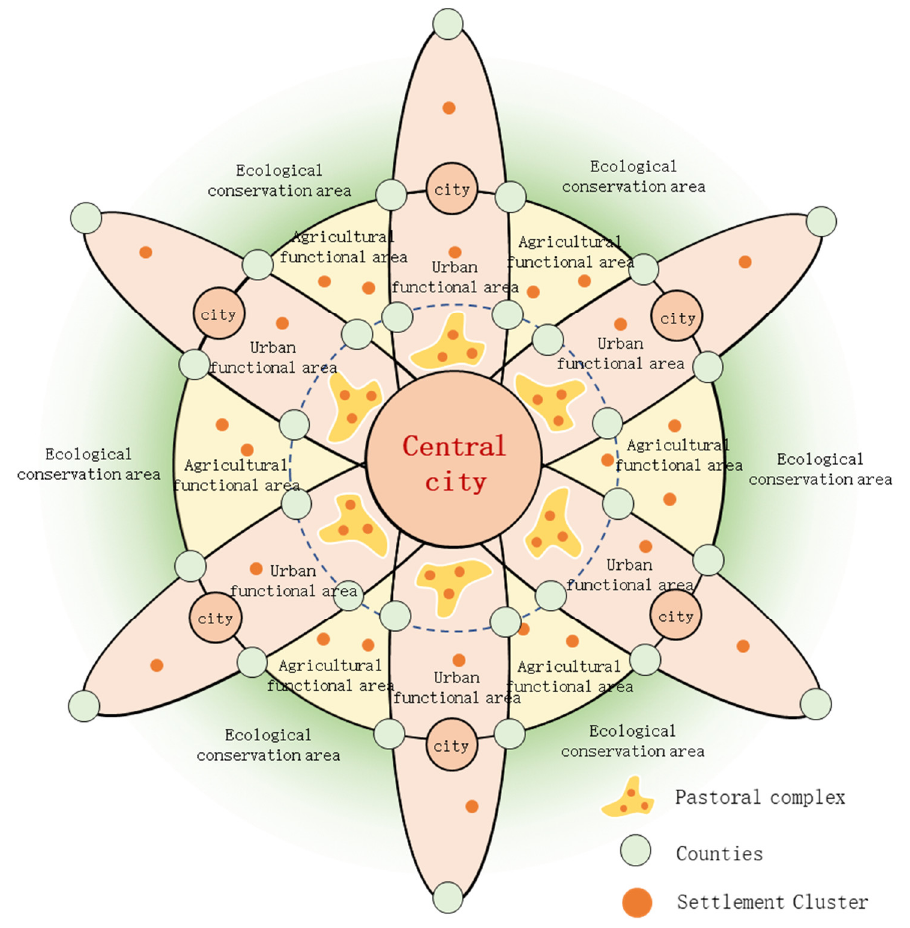
Figure 8. Spatial structure pattern of Wuhan metropolitan area.